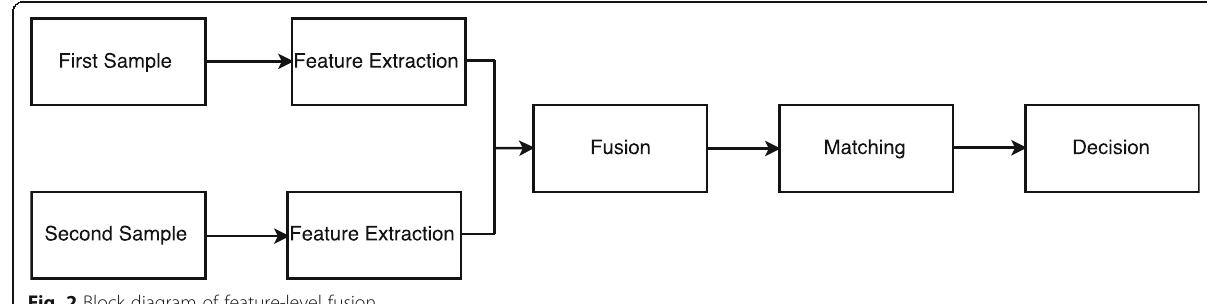
Fig. 2 Block diagram of feature-level fusion